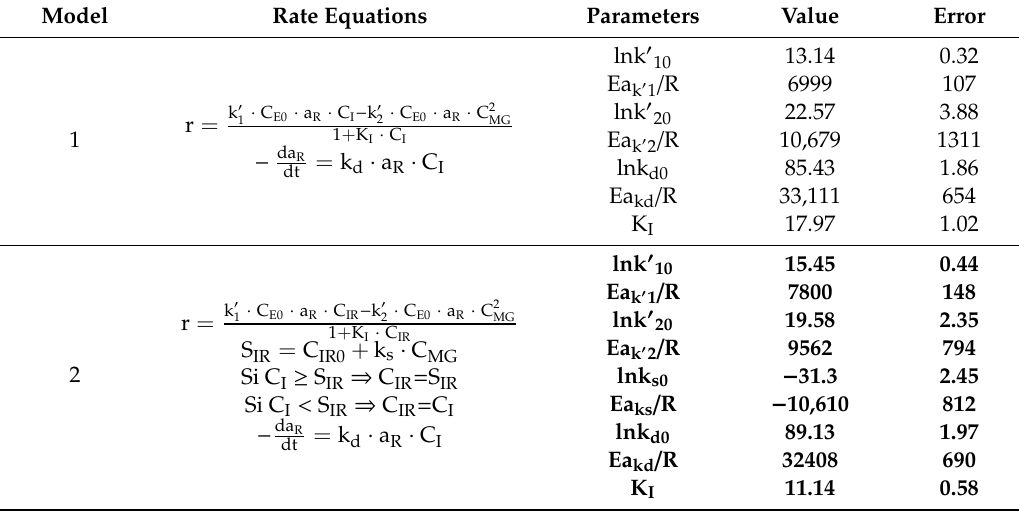
Table 2. Kinetic models with their kinetic constants, with the standard error for each constant, tested by fitting the retrieved data of the enzymatic esterification of ibuprofen and glycerol. In bold, the kinetic parameters, together with their values and errors, which correspond to the selected kinetic model.